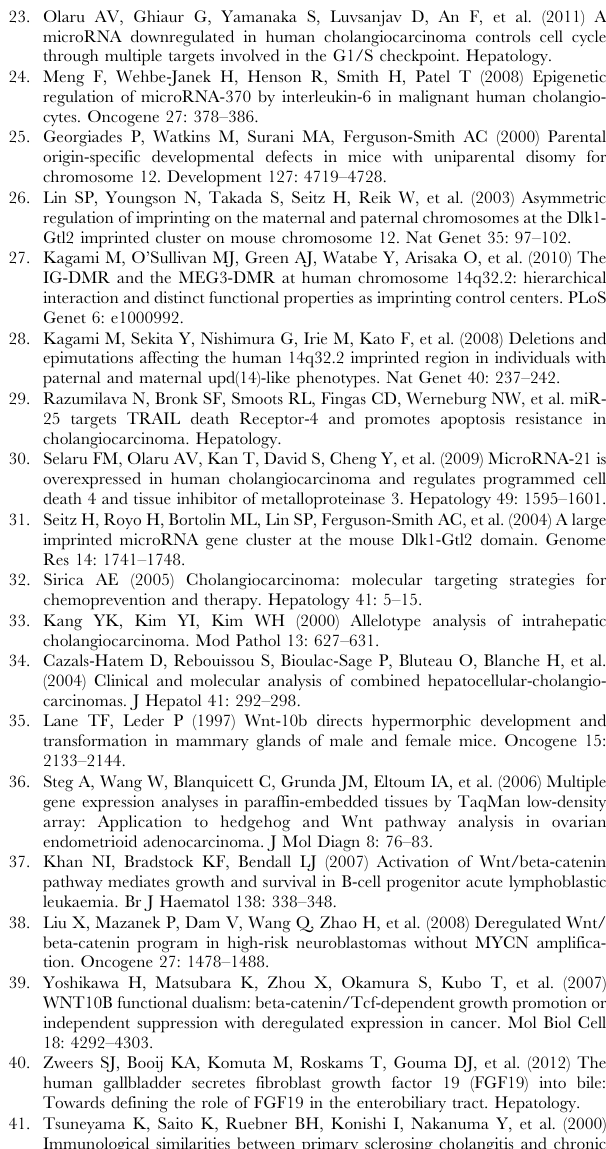
Figure S4 miR-370 is upregulated to physiologic